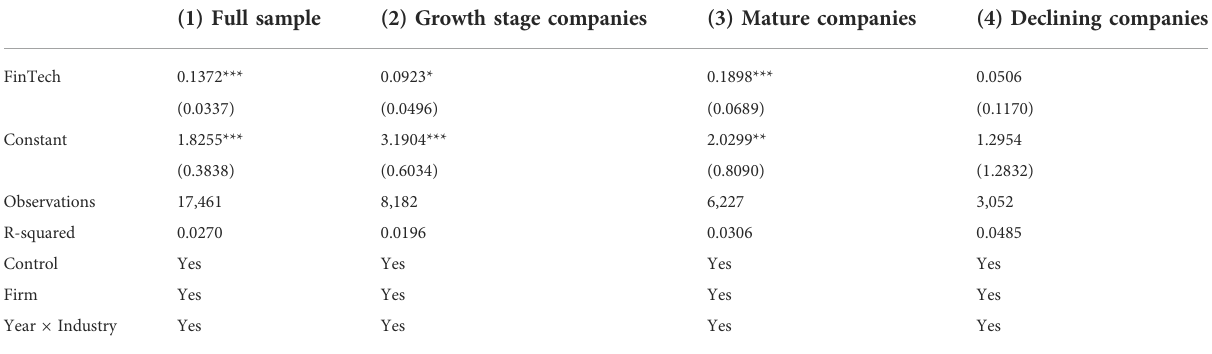
TABLE 9 Further tests based on business life cycle